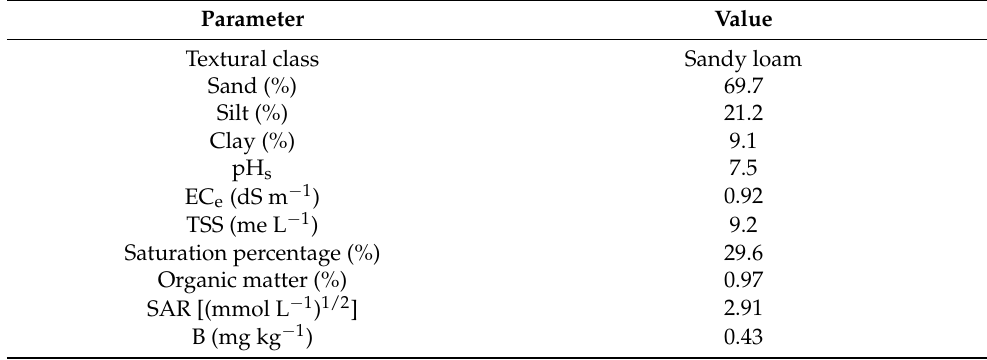
Table 1. Properties of soil used in the